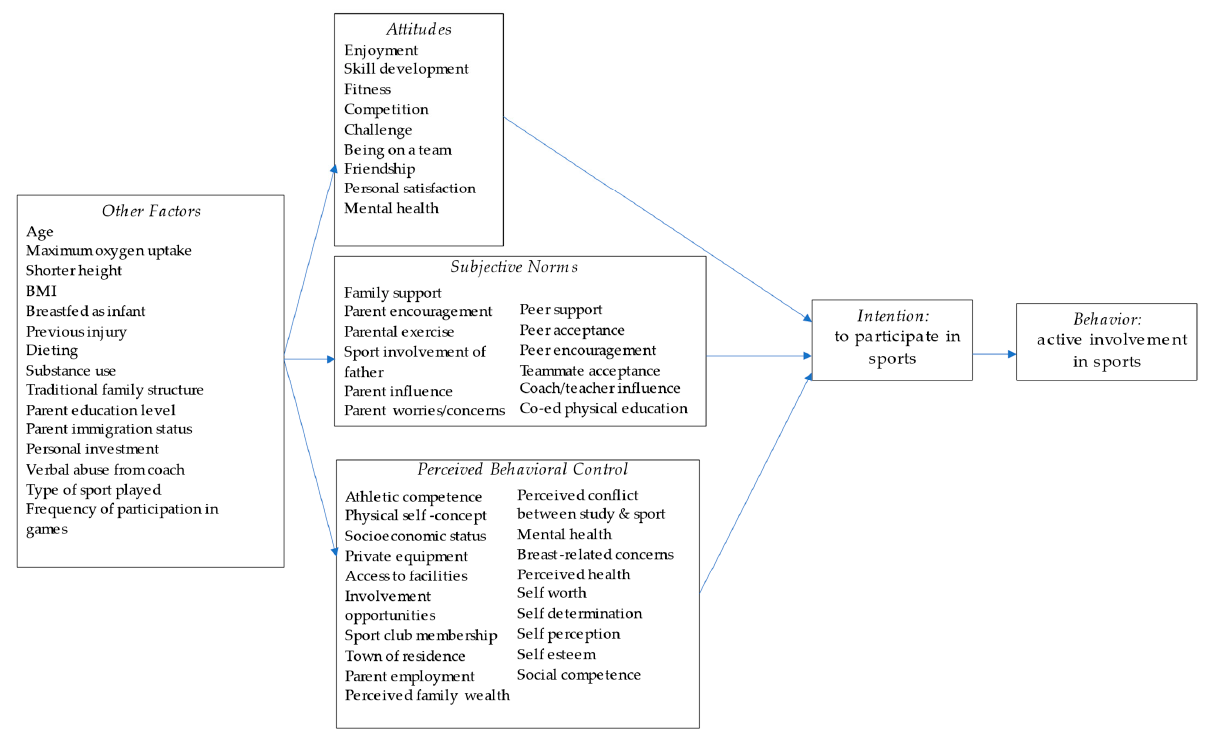
Figure 2. Adapted theory of planned behavior model with operationalized study